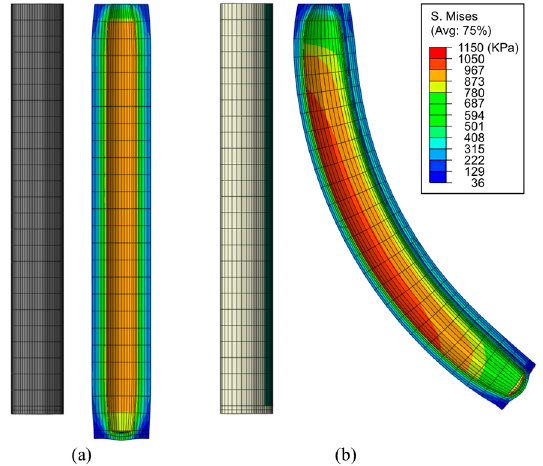
Figure 6. Effect of particle sedimentation on bending performance of soft bending actuator: ( a ) soft bending actuator with uniformly dispersed particles; ( b ) Soft bending actuator with particle sedimentation. (Color codes represent von Mises stress.)